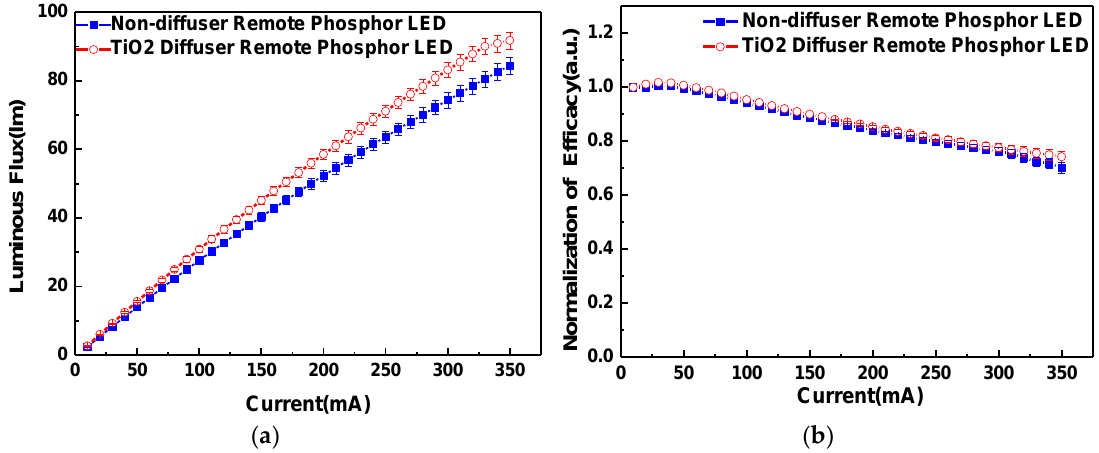
Figure 6. ( a ) Variations in output luminous flux and ( b ) normalization of efficacy as a function of injection current in non-diffuser and TiO 2 diffuser-loaded encapsulation remote phosphor LEDs.